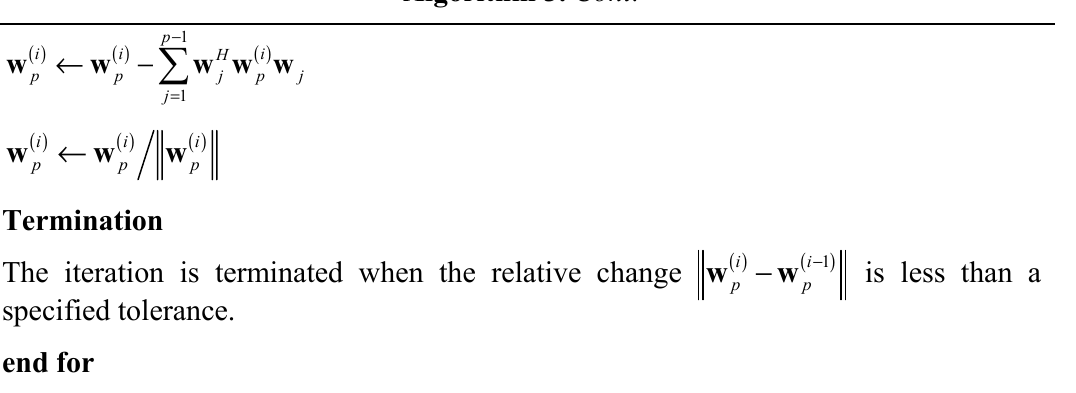
Algorithm 3. Cont.